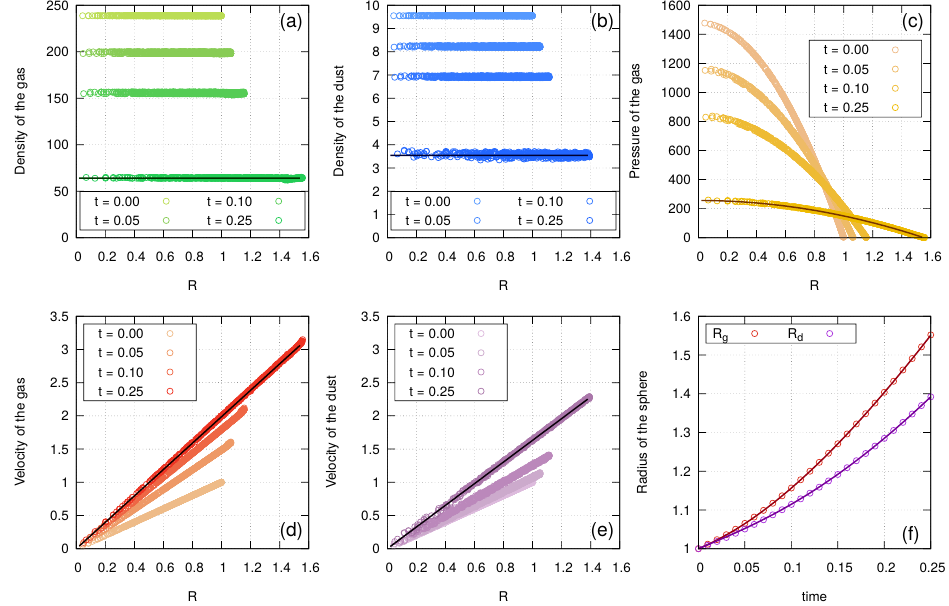
Figure 2. Expansion of a gas and dust ball into a vacuum, model M with ε = 0.04 and moderate relaxation time ( t stop = 0.1). The points show the computed values at four time moments t = 0, t = 0.05, t = 0.1, and t = 0.25, the solid bold line is the analytical solution at the final time t = 0.25. The panels represent (from left to right and from top to bottom): gas density ( a ), dust density ( b ), gas pressure ( c ), gas velocity ( d ), dust velocity ( e ), and radii of the gas and dust balls, respectively ( f